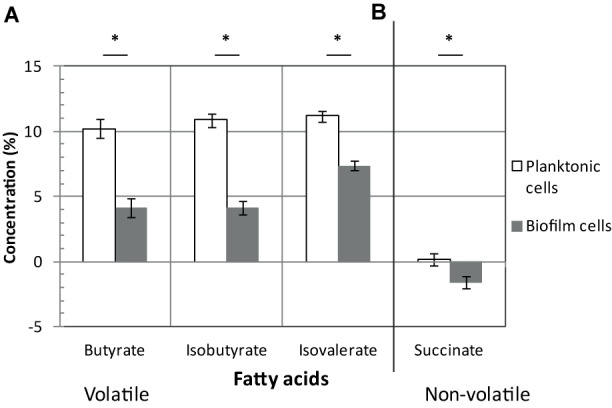
Fatty acids in biofilms/planktonic cultures. Strain 630Δerm was grown either as biofilms in microfermentors (like in Figure 1) or as planktonic cultures in Falcon tubes. Supernatants of biofilms (in gray) and planktonic cultures (in white) were recovered and their composition in volatile (A) and non-volatile fatty acids (B) was determined. Relevant fatty acids, as inferred from our transcriptomic study, are shown. ∗ indicates a statistically significant difference (p-value < 0.05). Pyruvate, lactate and isocaproate concentrations were not statistically different between biofilms and planktonic cultures.